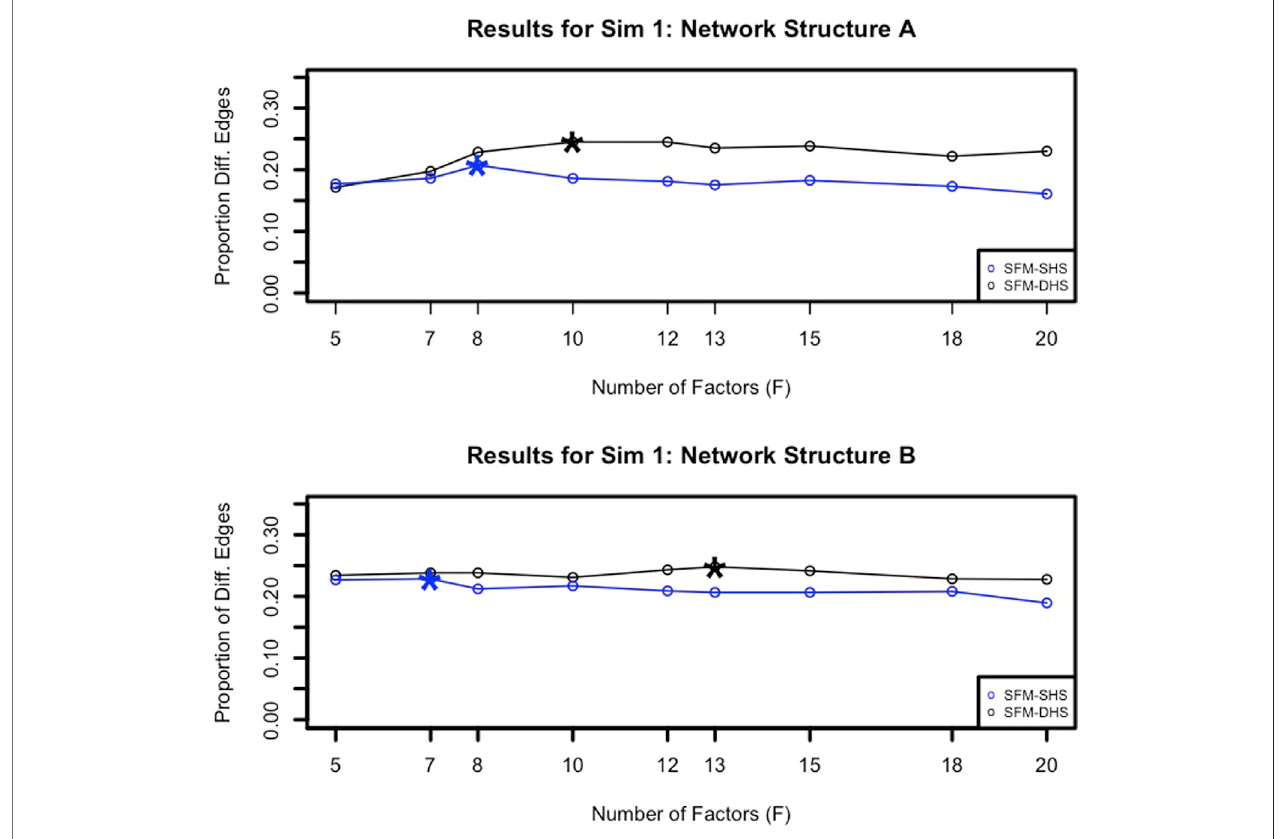
FIGURE3| Example proportionsofsigni fi cantdifferentialnetworkedges(numberofsigni fi cantdifferentialnetworkedgesdividedby G ( G − 1 ) and SFM-DHS withbootstrap estimationfordifferentchoices of F fromSim1.The + symbols denotetheconsidered “ peak ” pointsacrossthedifferentnumber offactor